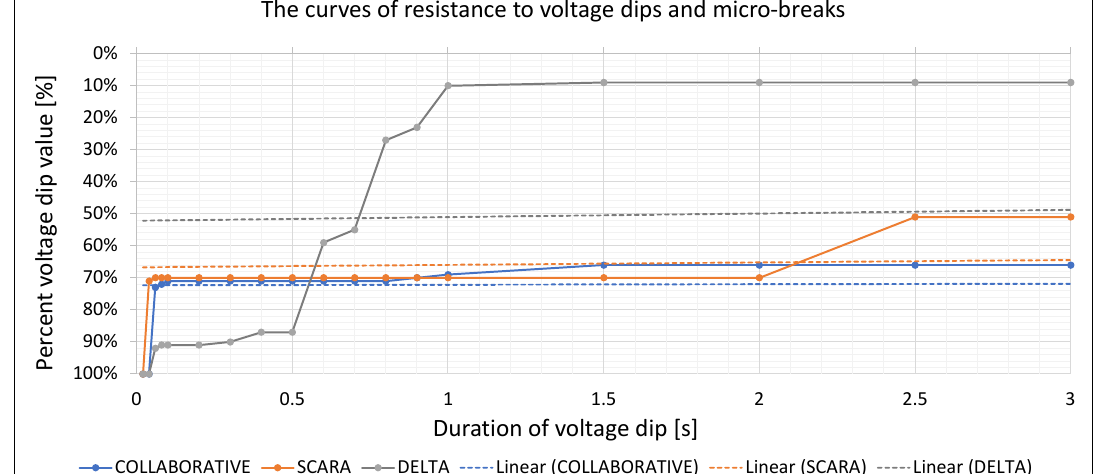
Figure 6. The robustness curves of individual robots for dips and micro-breaks in the power sup- ply.